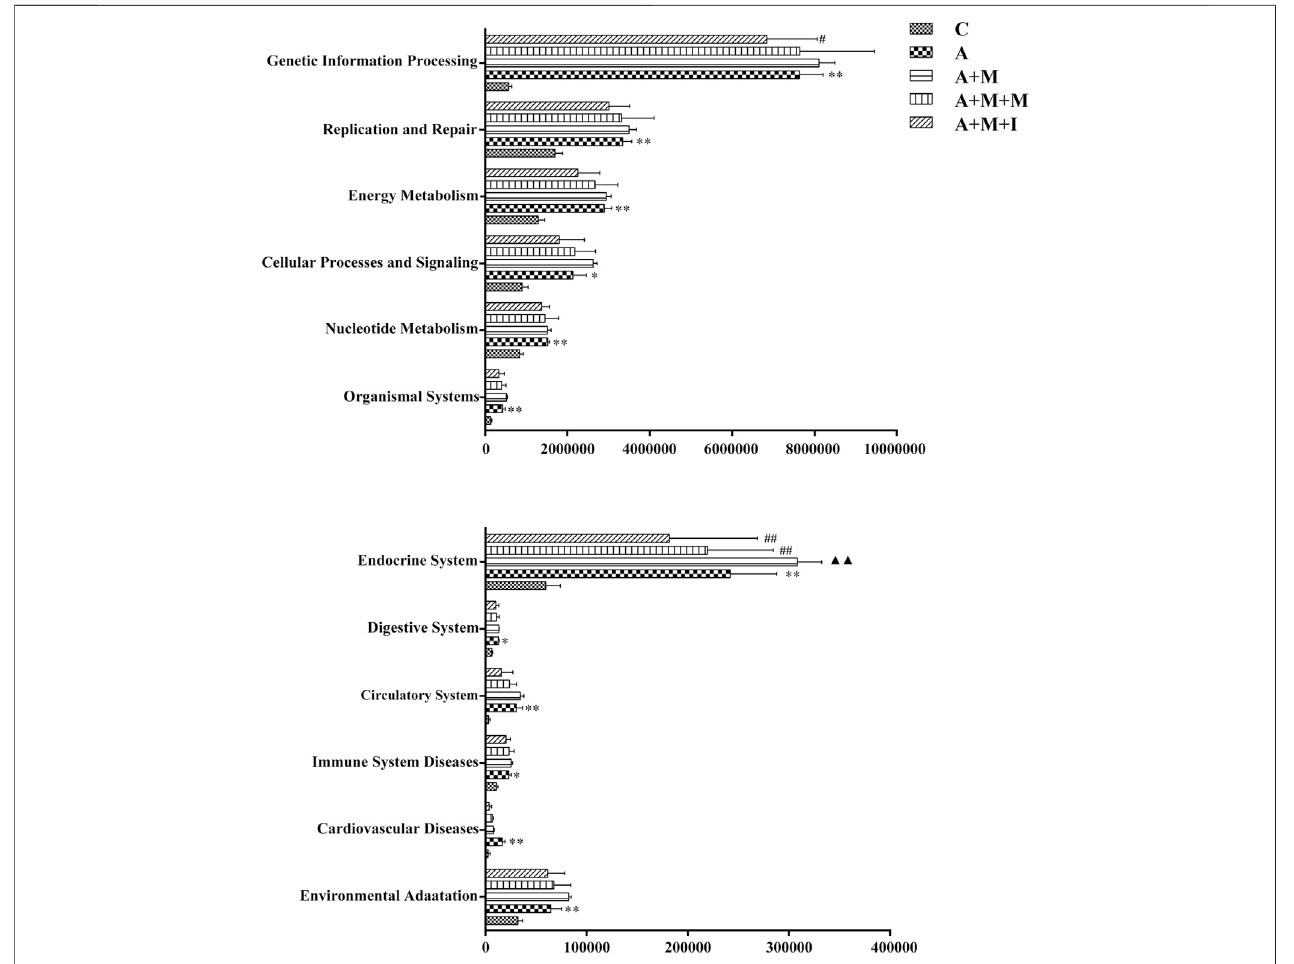
FIGURE13| DifferentiallyregulatedfunctionalpathwaysbasedonKEGGenrichmentanalysisinferredfrom16SrRNAgenesequencing usingPICRUSt.* p < 0.05, ** p < 0.01 vs the control (C) group; # p < 0.05, ## p < 0.01 vs the A + M treatment group; ▲ p < 0.05, ▲▲ p < 0.01 vs the antibiotic (A) treatment